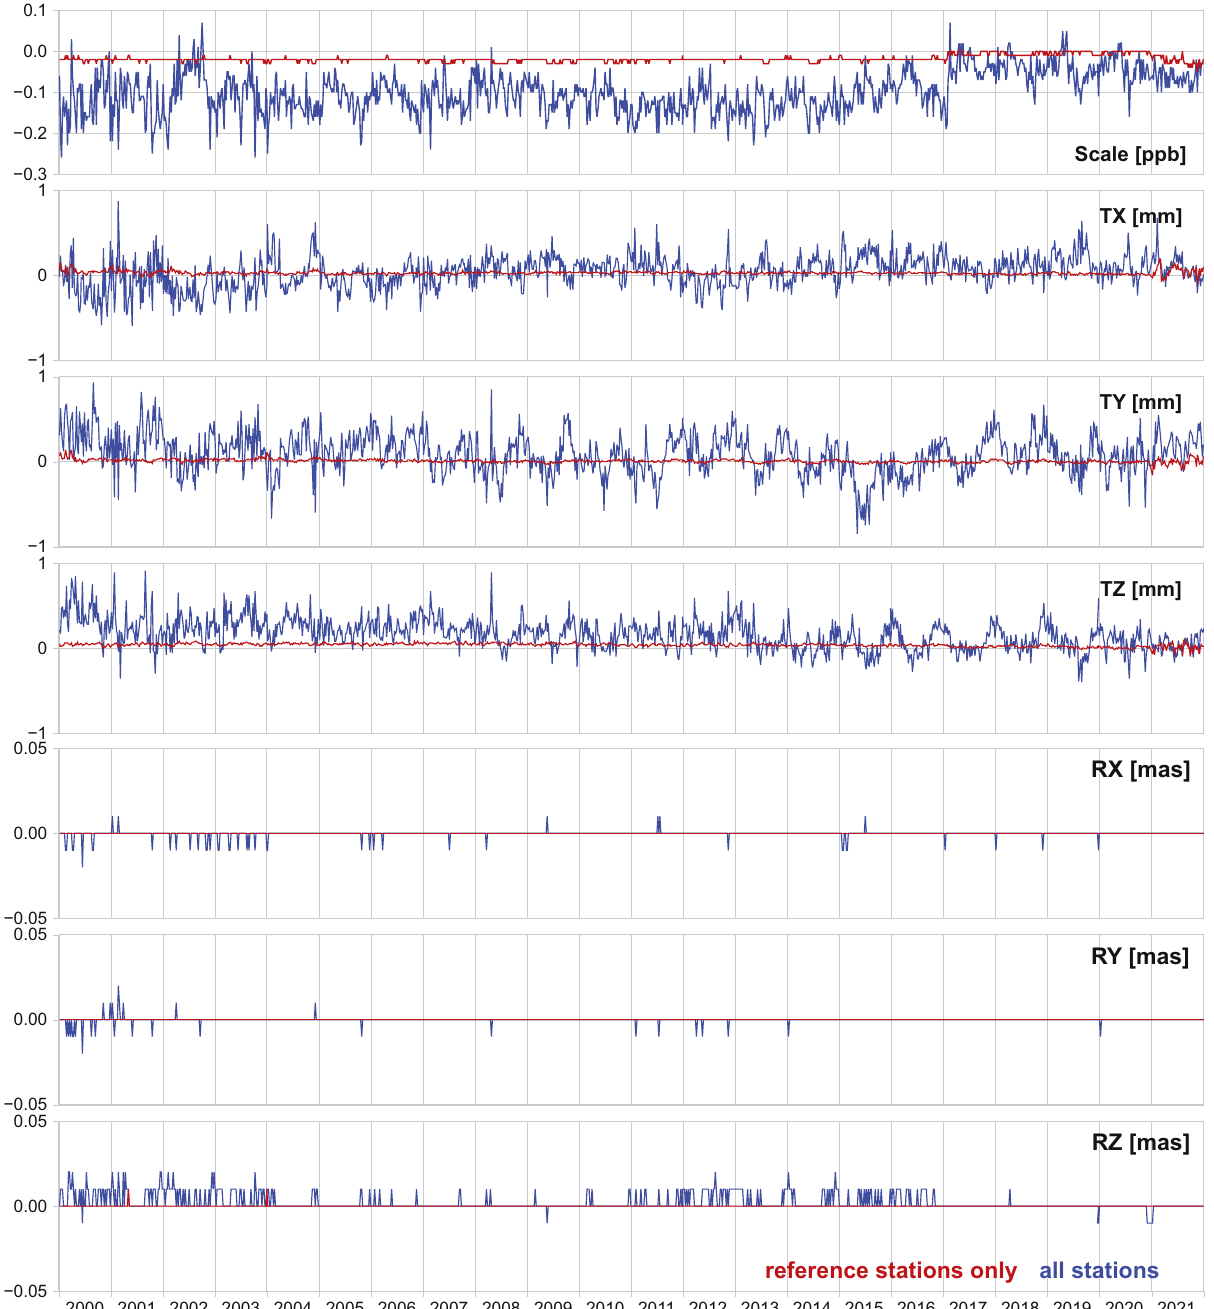
Figure 12: Di ff erences in scale, translation, and rotation parameters between the SIRGAS - Repro2 station positions and the weekly coor - dinates of the IGS stations in IGS14/IGb14. Red lines represent parameters determined using fi ducial stations only, while blue lines represent the values obtained when using all SIRGAS/IGS common